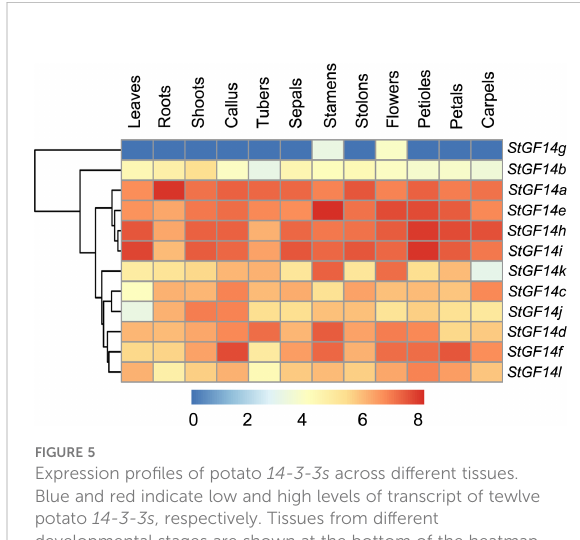
FIGURE 5 Expression pro fi les of potato 14-3-3s across different tissues. Blue and red indicate low and high levels of transcript of tewlve potato 14-3-3s , respectively. Tissues from different developmental stages are shown at the bottom of the heatmap.